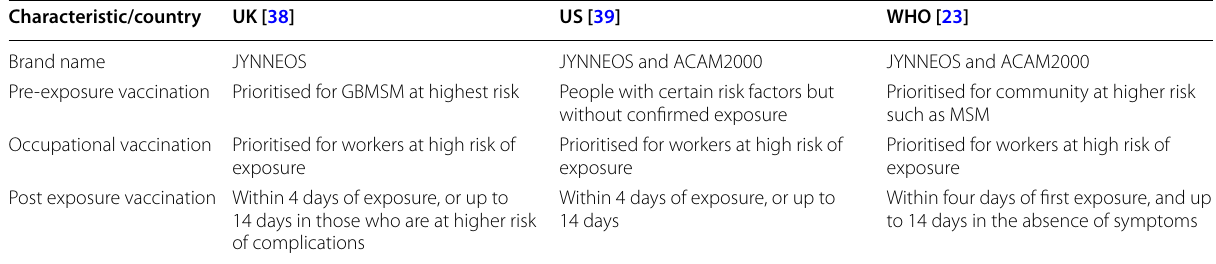
Table 1 Vaccination policies recommendations in United Kingdom, United States and World Health Organization